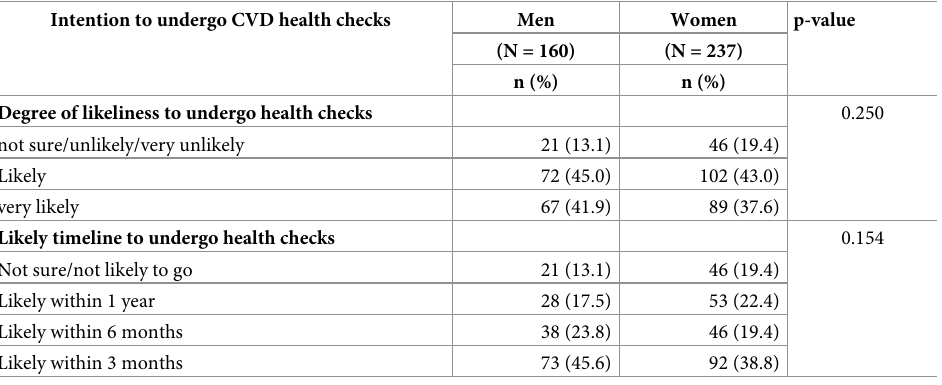
Table 2. Intention to undergo CVD health checks among men and